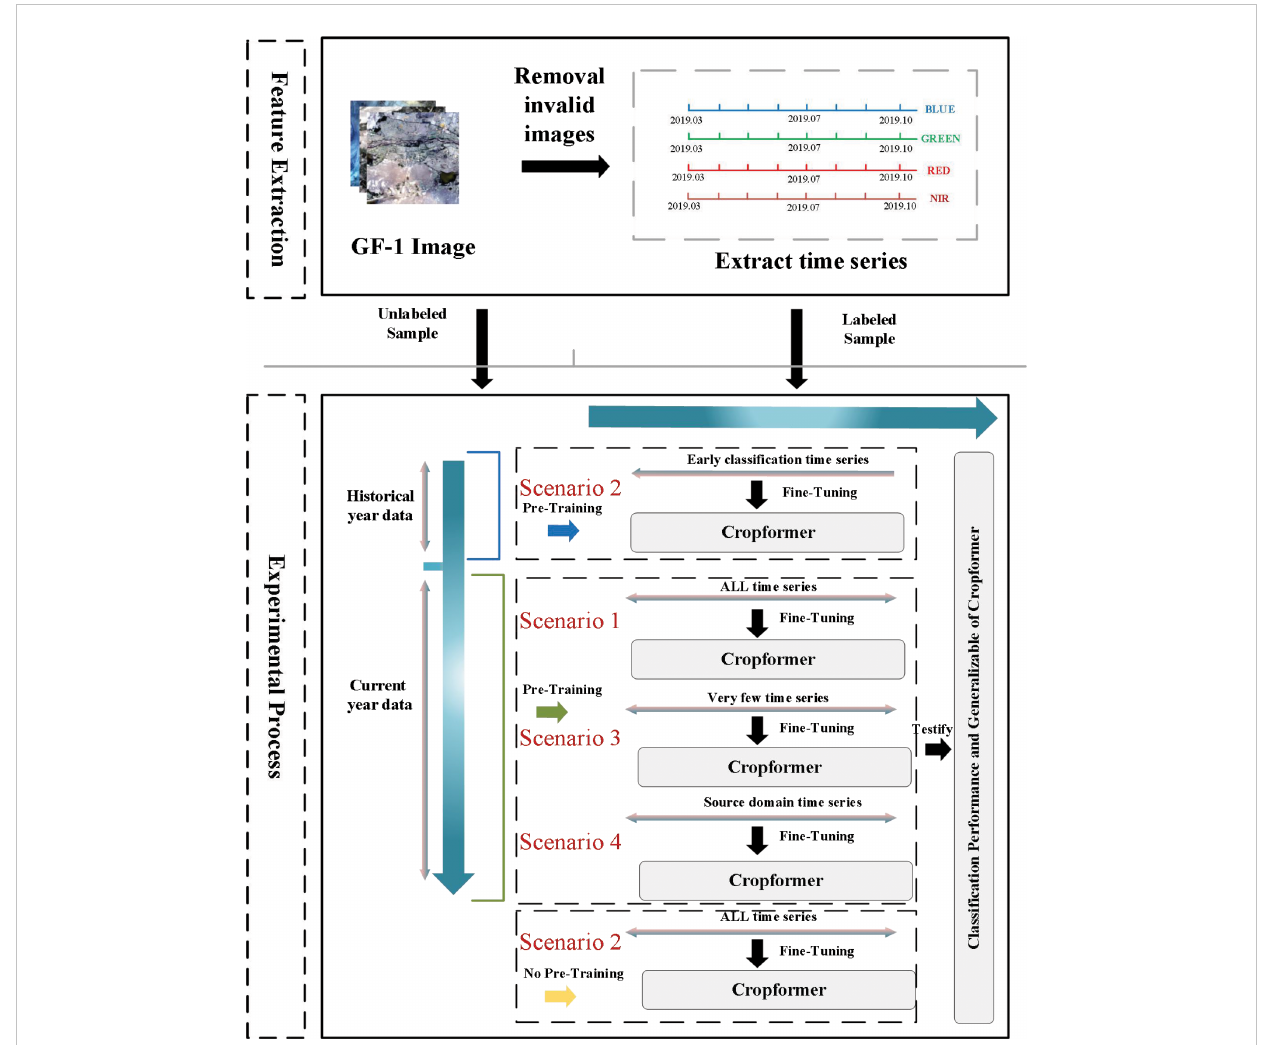
FIGURE 6 The experimental process uses historical data and current year data as pre-training data. The acquisition time of image data is from March to October. The bands used are blue, green, red, and near-red. The red serial number represents the number of crop classi fi cation